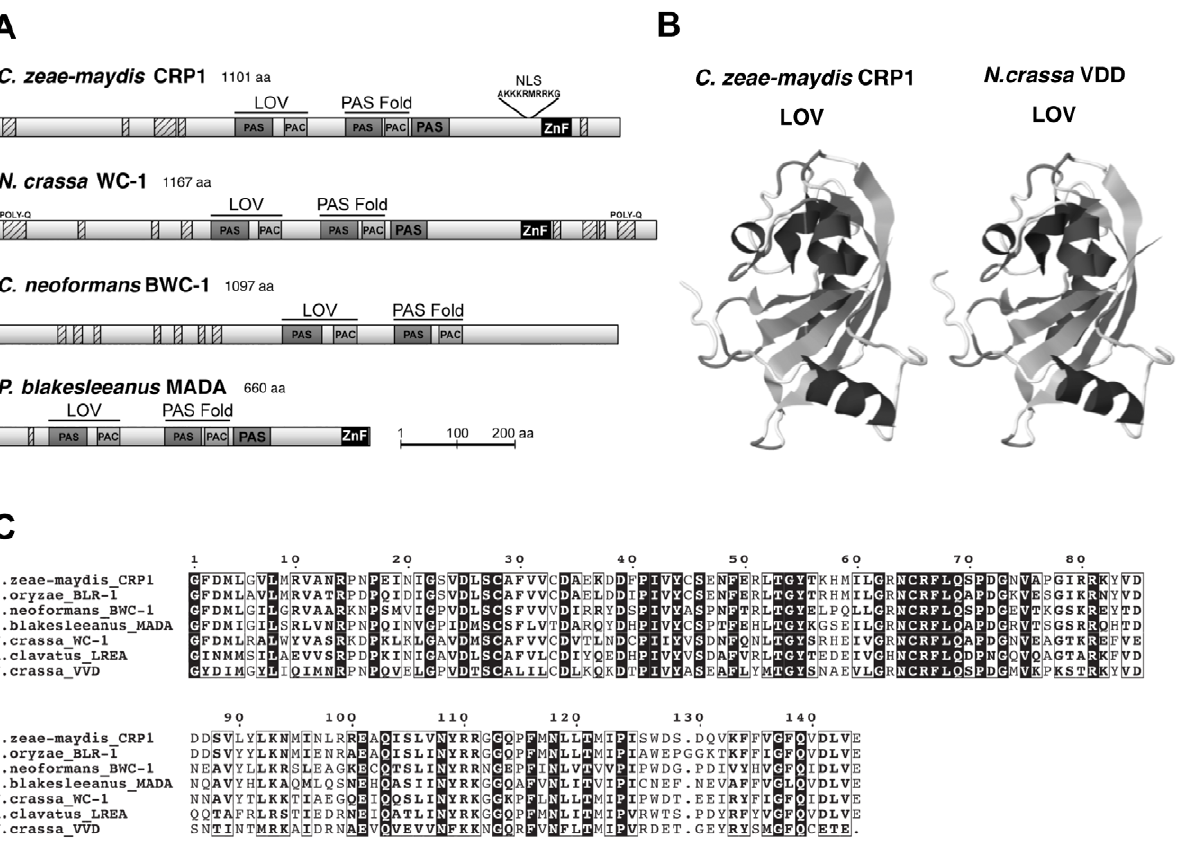
Figure 3. CRP1 encodes a putative ortholog of the N.crassa protein WC-1. A, Conceptual translation of CRP1 revealed a protein predicted to contain at least four functional domains (LOV, PAS-Fold, PAS, and ZF) represented by shaded boxes. Diagrams of WC-1 and putative orthologs are presented to illustrate homology. Boxes with hash marks represent predicted low-complexity regions, NLS indicates a nuclear localization signal. B, Comparison of LOV domains from Crp1 of C. zeae-maydis and VVD of N. crassa . C, Alignment of the LOV domains encoded by vvd and putative wc-1 orthologs from fungi.